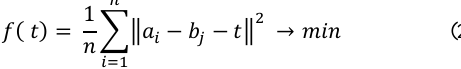
Figure 6. From top to bottom: building overlaid with surface points and the CCA result; bounding rectangles (virtual points); bounding rectangles (surface points).